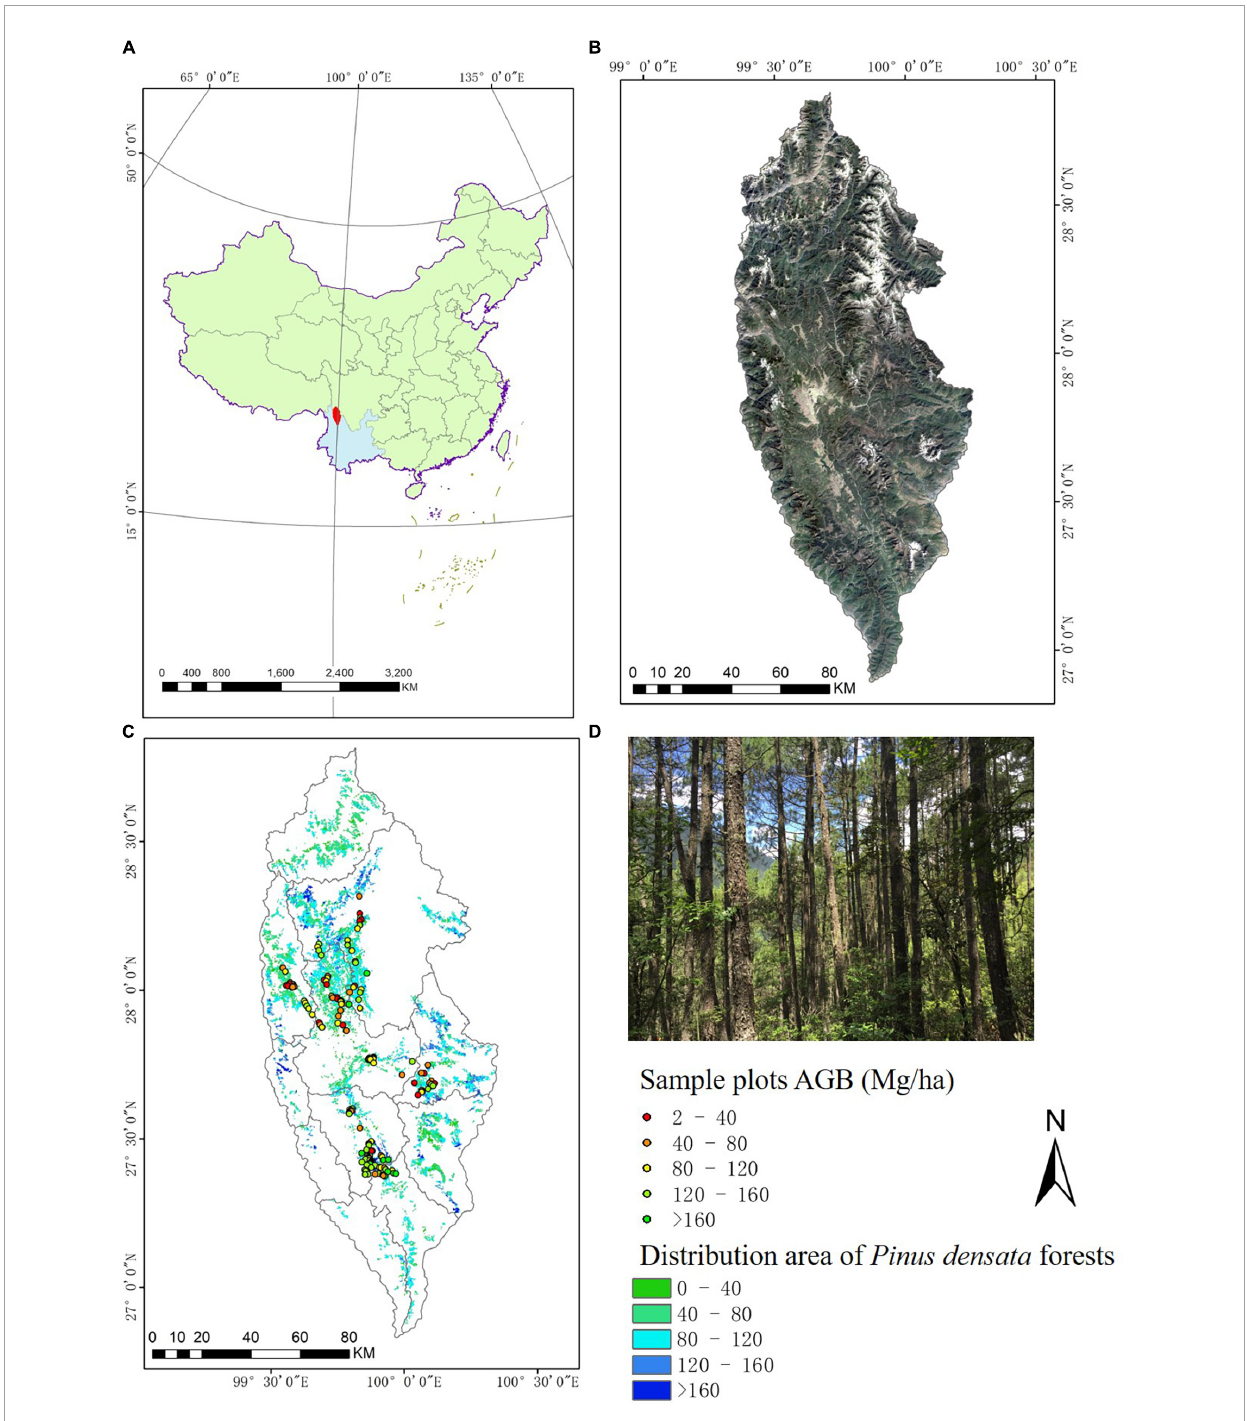
FIGURE1 (A) The location of the study area; (B) Shangri-la City shown by a composite image; (C) the spatial distribution of Pinus densata forests according to the forest management inventory (FMI) data in 2016 and the sample plots investigated in 2016; (D) Pinus densata forests in the study area.